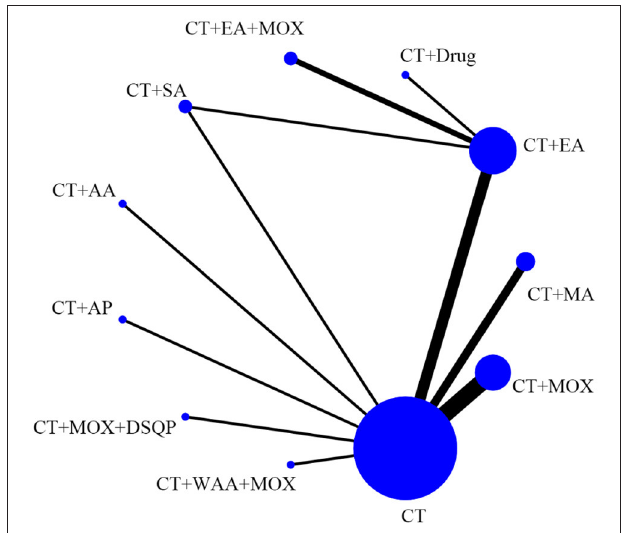
FIGURE 5 | Network of eligible comparisons for the network meta-analysis of RUV. Each node represents an intervention and the size of each node represents the number of randomly assigned participants. Each line represents a direct comparison between interventions and the width of the lines represents the number of studies.